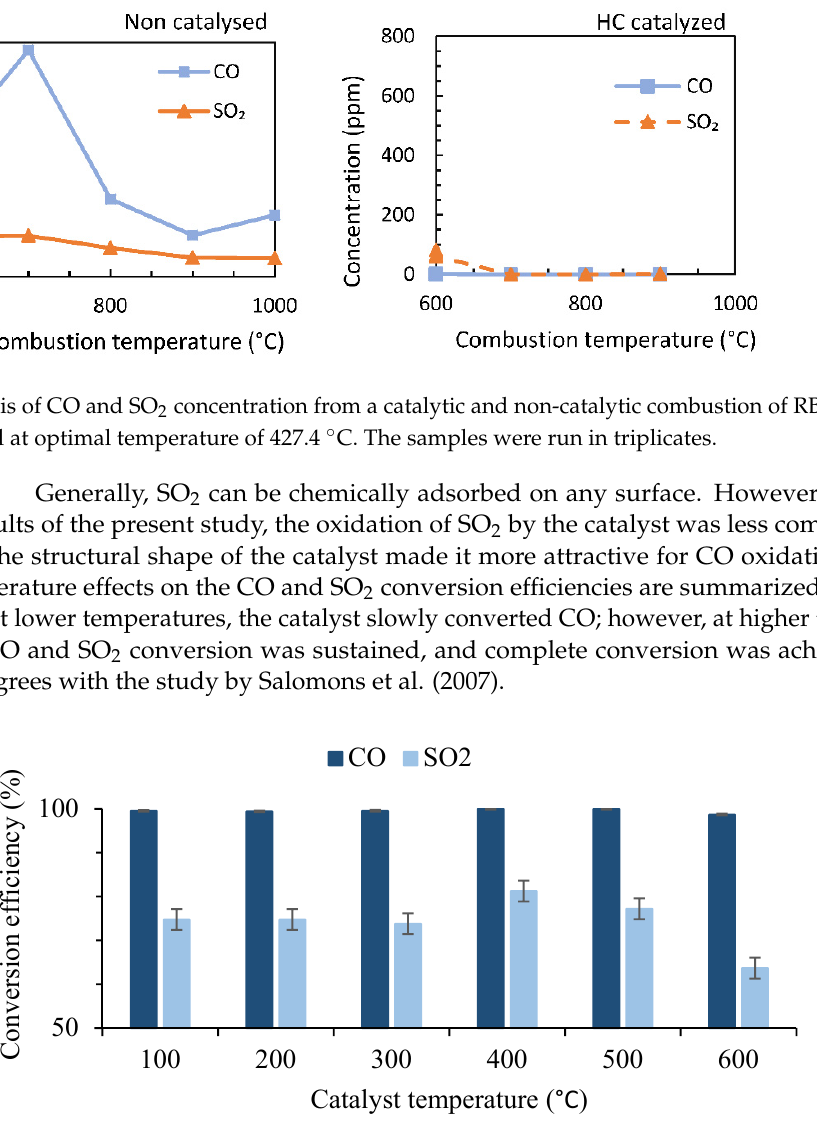
Figure 10. Temperature effects (rounded to the nearest 100) on CO and SO 2 conversion efficiencies.